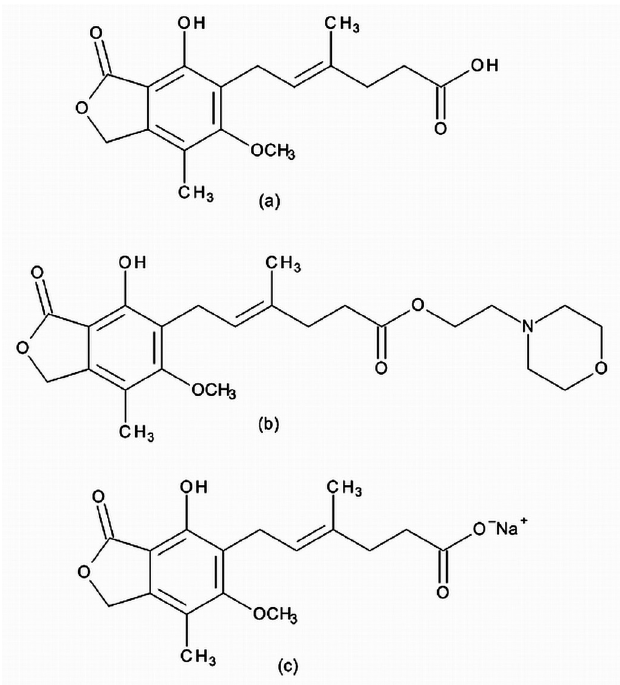
FIGURE 1 – Chemical structures of (a) mycophenolic acid, (b) mycophenolate mofetil and (c) mycophenolate